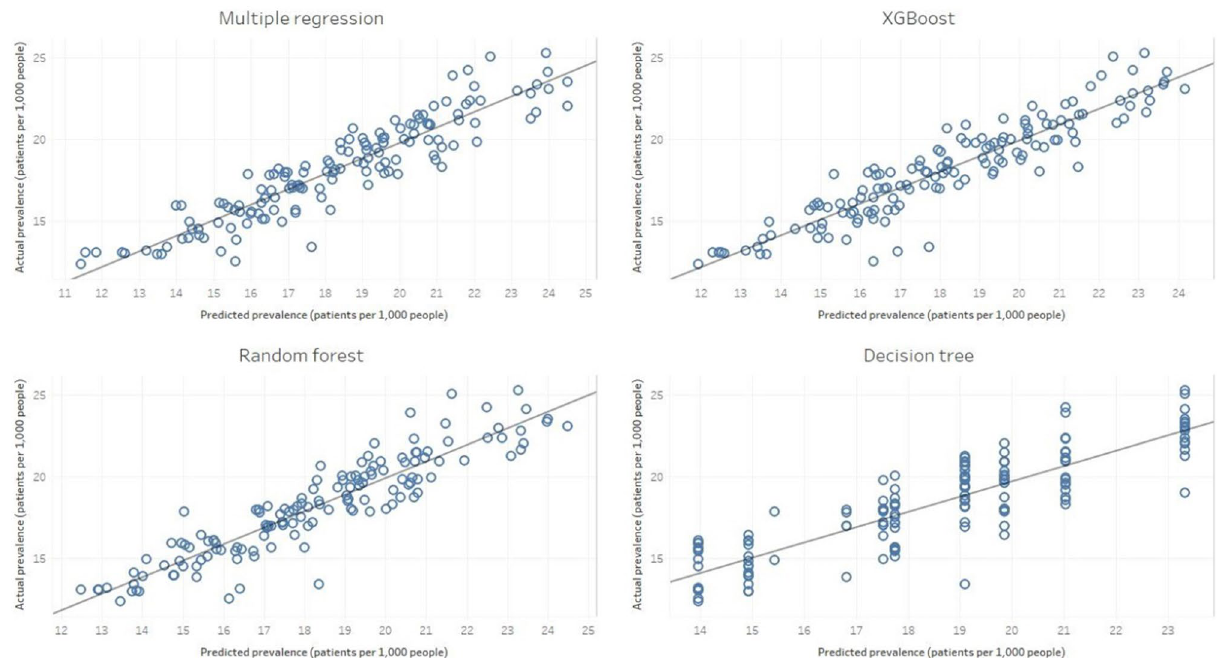
Figure 4. Predicted prevalence to actual prevalence for each model. The XGBoost model shows the most accurate prediction model and the decision tree model shows the least accurate prediction.